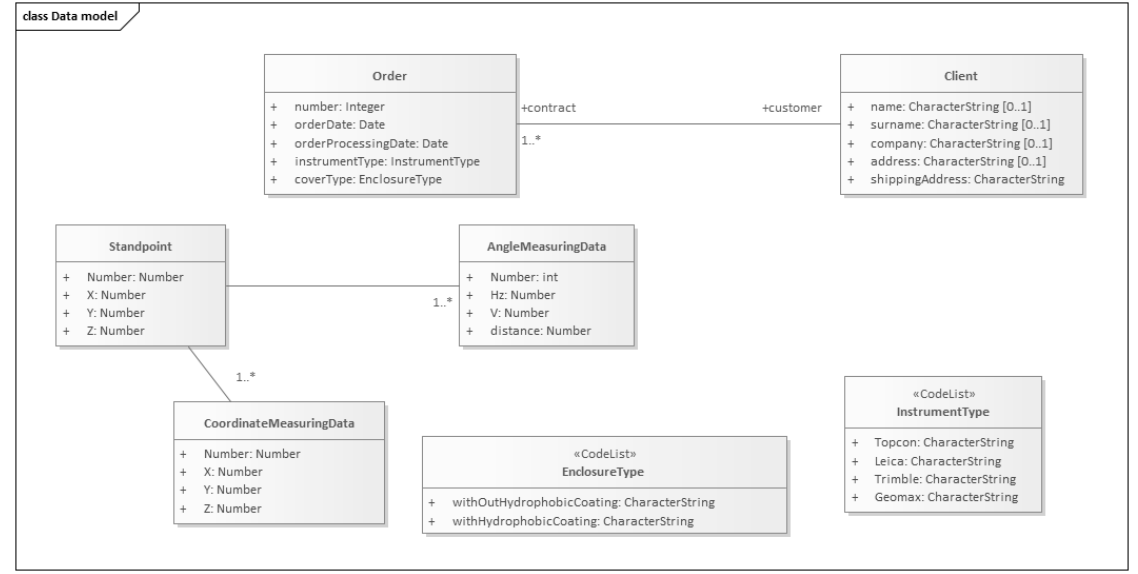
Figure 9. Conclusively formalized data model compliant with ISO 19100.